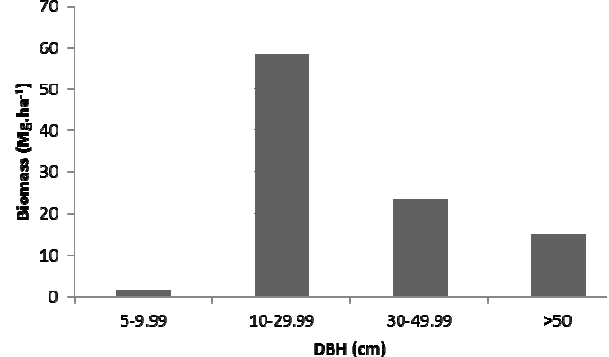
Fig. 5. Distribution of above ground biomass of tree species in different DBH classes Table 3. Pearson’s correlation for diversity parameters